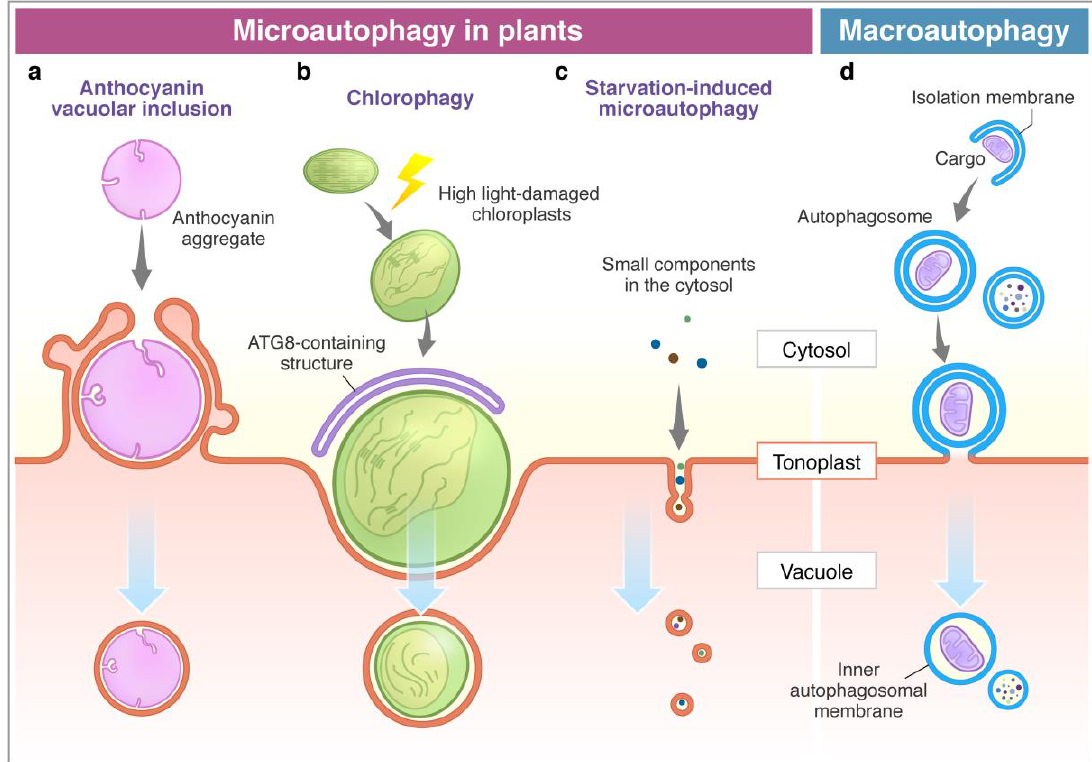
Figure 1. Microautophagy processes in plants. Comparison between microautophagy ( a – c ) and macroautophagy ( d ). ( a ) Cytosolic anthocyanin aggregate is surrounded by the protrusion of the vacuolar membrane and sequestered into the vacuole [68]. ( b ) High light-damaged swollen chloroplast invaginates toward the vacuole with the association of the ATG8-containing structure. This process requires ATG genes (ATG5 and ATG7) [69]. ( c ) Sucrose starvation induces tubule formation on the tonoplast, and then vesicles are generated. Small components, such as cytosolic proteins and cytosolic acid granules, can be transported into the vacuole via this process. This process is suppressed by lack of ATG2, ATG5, and ATG7 [71]. The membrane of autophagic bodies generated via microautophagy consists of the tonoplast ( a – c ). ( d ) The macroautophagy process is initiated with the enclosure of cargoes by the isolation membrane in the cytosol to form an autophagosome. After the fusion of the outer membrane of the autophagosome with the tonoplast, it generates an inner membrane-surrounded autophagic body.